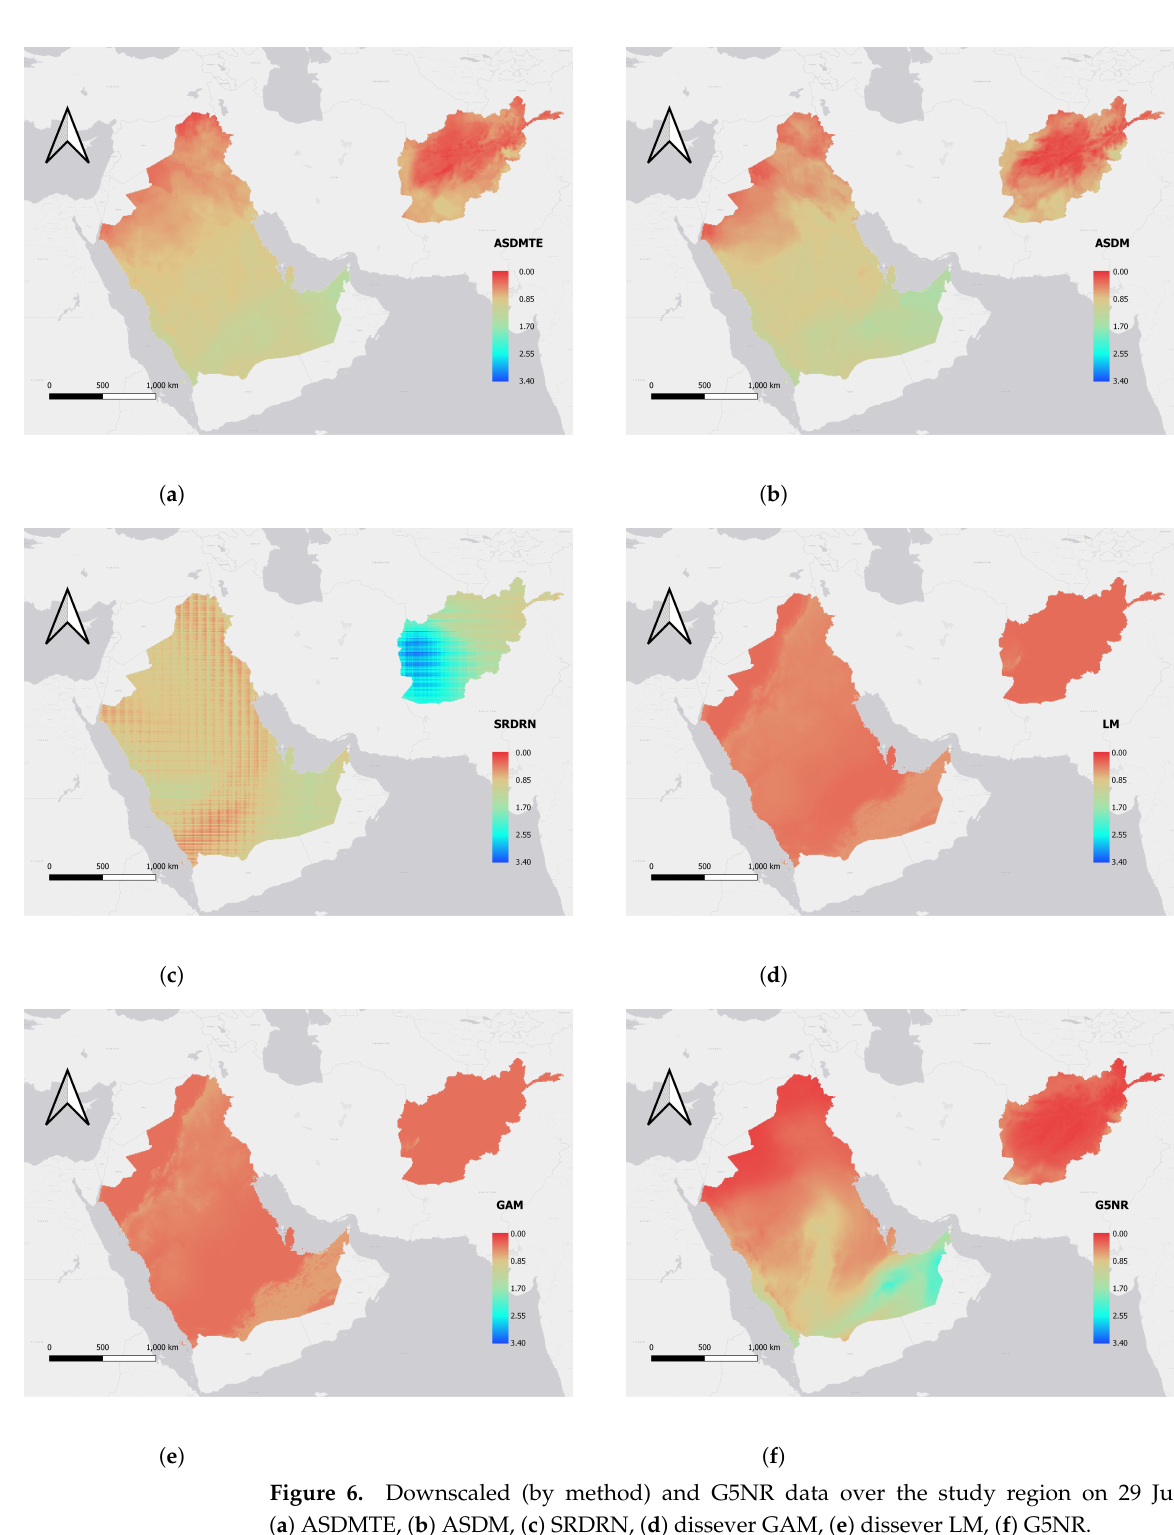
Figure 6. Downscaled (by method) and G5NR data over the study region on 29 July